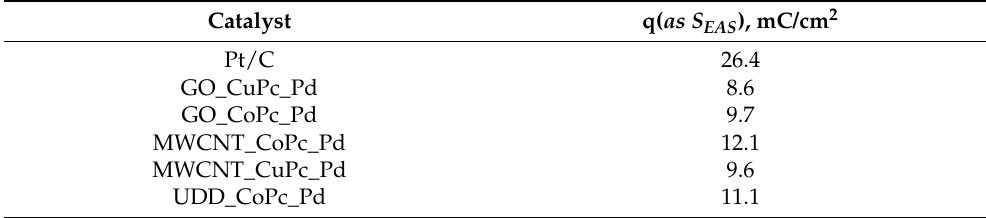
Table 4. Electrochemical active surface values (S EAS ) for the catalysts ( ϑ = 50 mV/s ).